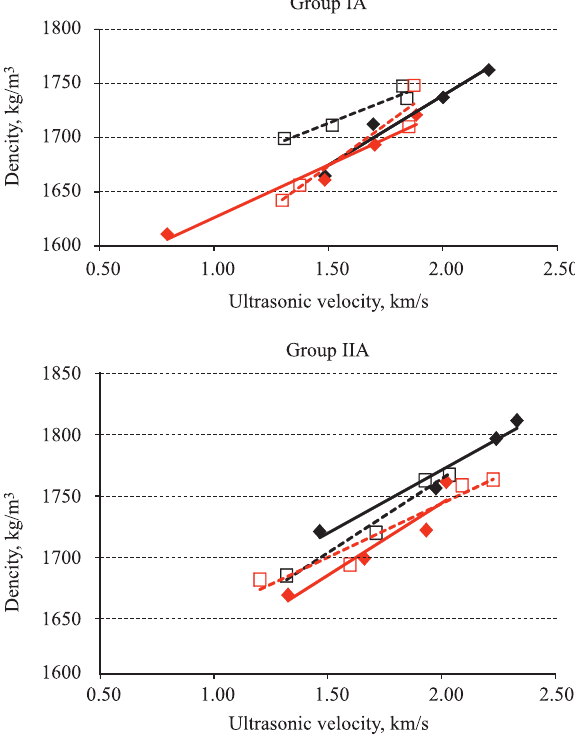
Fig. 3. Relationship between density and ultrasonic velocity for stabilized